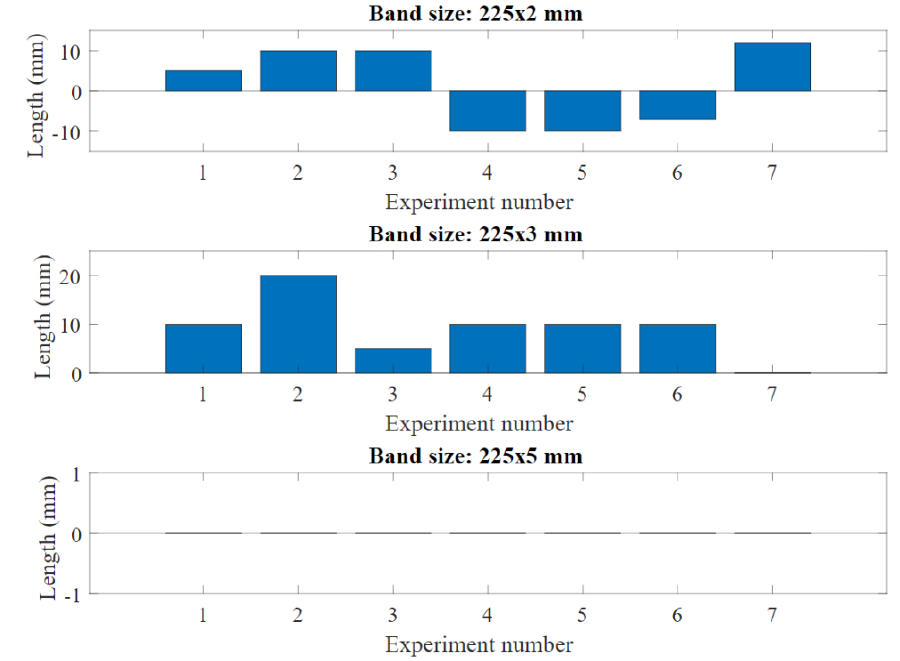
Figure 14. The length changes for all bands used in the experiment.